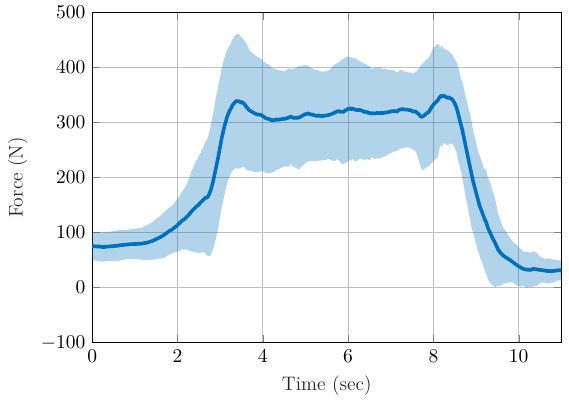
Figure 12. Rope force measured during sit down and stand up